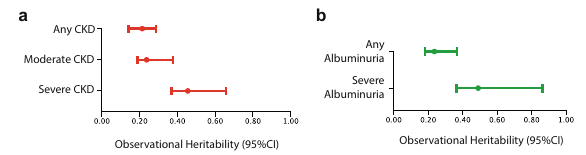
Fig. 3 EHR-based observational heritability (h o2 ) of renal function and albuminuria. a h o2 of eGFR (quantitative trait) in families with any CKD, moderate CKD (G-stage 3 or greater) and advanced CKD (G-stage 4 or greater) b h o2 of albuminuria (A2 and A3, dichotomous) and severe albuminuria (A3, dichotomous). Bars correspond to 95% con fi dence intervals around the point